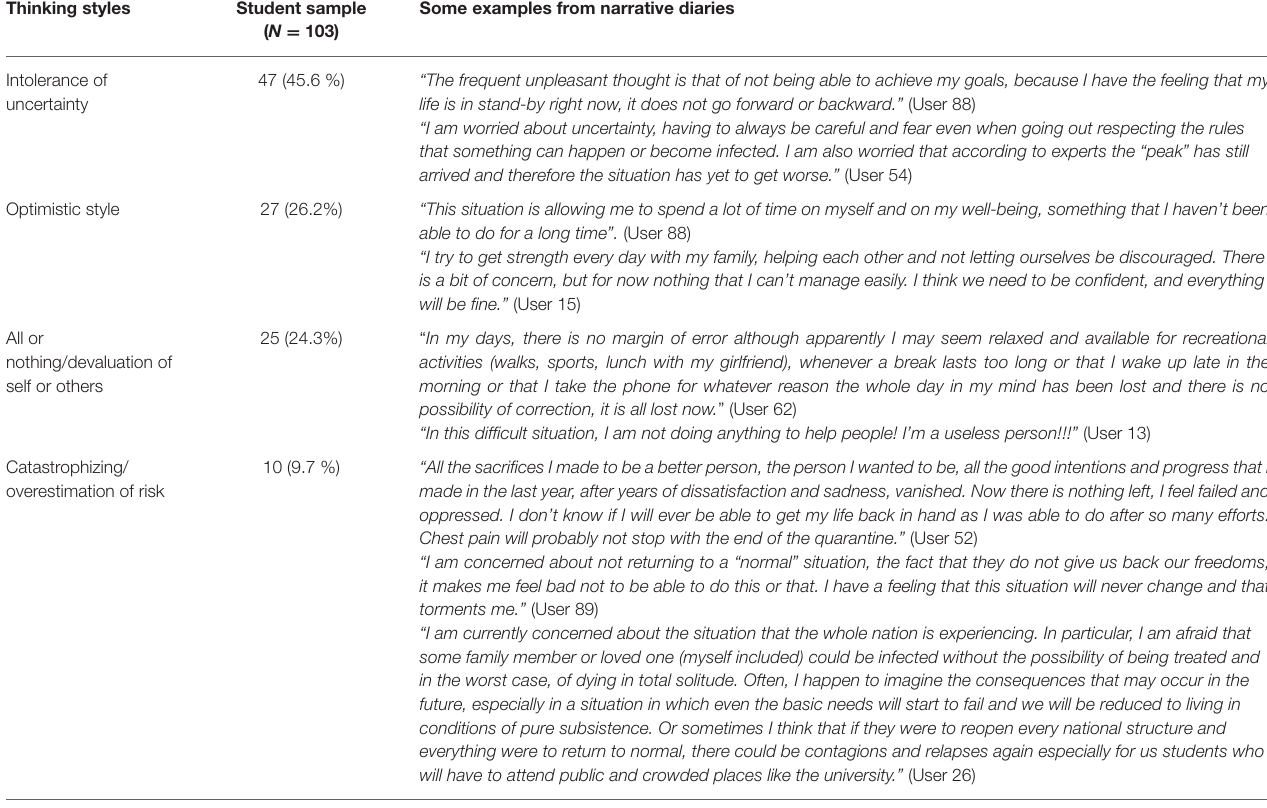
TABLE 4 | Thinking styles reported by students in their lockdown digital narrative diaries. Thinking